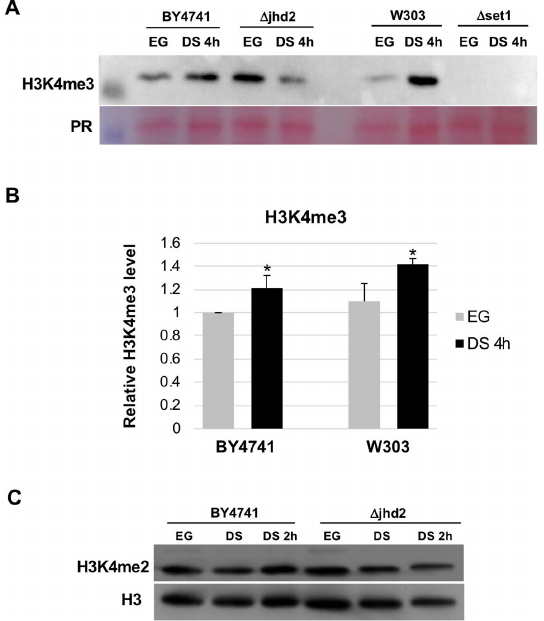
Figure 1. ( A ) Western blot showing H3K4me3 level in wild type (BY4741, W303) and mutant ( Δ JHD2, Δ SET1) strains during exponential growth (EG) or 4 h after diauxic shift (DS). The phenol red stain of histones is reported as loading control. ( B ) Quantitation of H3K4me3 at EG and 4 h after DS in wild type strains. n = 3, standard deviation is indicated. * = p < 0.05 according to Student’s t - test. ( C ) Western blot showing the level of H3K4me2 during EG, DS and 2 h after DS in the BY4741 and Δ JHD2. The histone H3 is the endogenous calibrator.